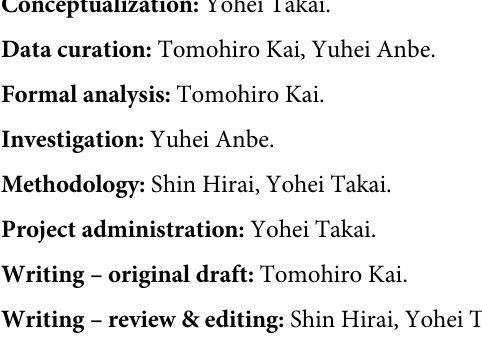
S1 Fig. An example of typical trajectory data and kinematic data (speed, acceleration, jerk and direction of speed) in each angle when one player performed CODs in directions determined by 13 set angles (every 15˚, ranging from 0˚ to 180˚). A: 0˚, B: 15˚, C: 30˚, D: 45˚, E: 60˚, F: 75˚, G: 90˚, H: 105˚, I: 120˚, J: 135˚, K: 150˚, L: 165˚, M: 180˚. A bold line over- lapped in line plot indicates an analytical period. S2 Fig. The time-series data for jerk with and without the filtering process are presented. The use of cutoff frequencies of 3–6 Hz resulted in noise in the smoothed time-series data, while cutoff frequencies < 2 Hz produced less noise. Thus, a 2 Hz cutoff frequency was